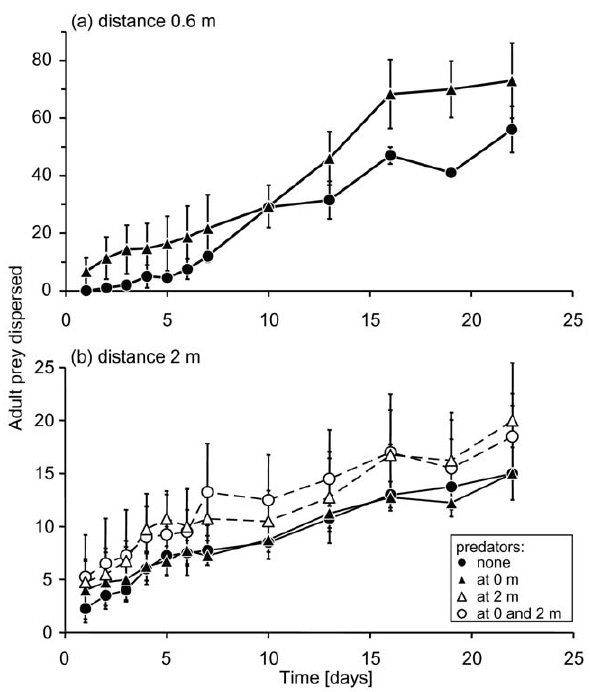
Figure 2. The average ( 6 s.e.m.) numbers of adult whiteflies that dispersed from a release plant to 4 neighbouring plants through time. (a) Distance between neighbouring plants 0.6 m. Predators were either released on the same plant as the whiteflies (at 0 m) or no predators were released (none). (b) Distance between neighbouring plants 2 m. Predators were either released on the same plant as the whiteflies (at 0 m), on the plant closest to the release plant (hence, at 2 m), on the same plant as the whiteflies and on the neighbouring plant (at 0 and 2 m), or no predators were released (none). See legend to Figure 1 for further